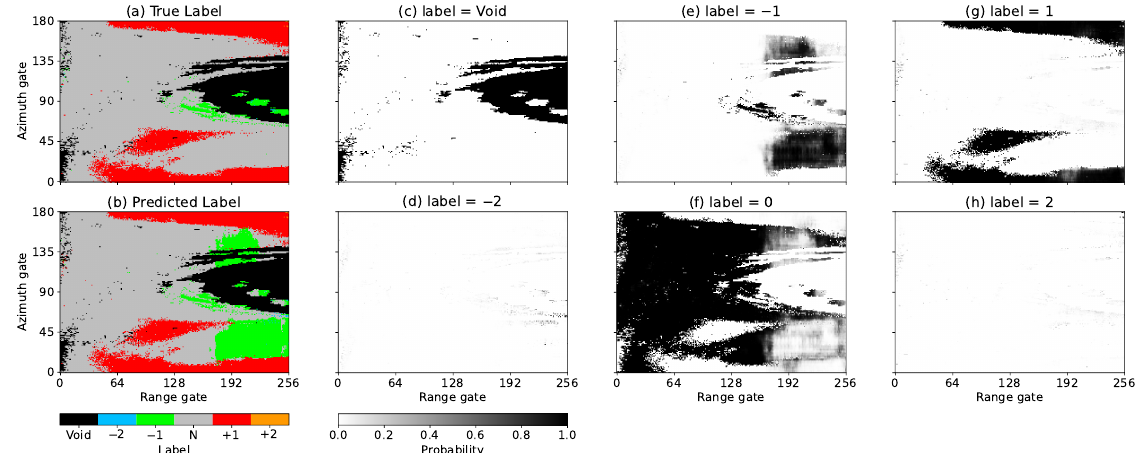
Figure 5. An example of failed prediction with non-speckle echoes: Panel ( a ) shows the true label, which is synthesized using a 0.88 ◦ -EL scan from the KTLX on 16 January 2017 06:33 UTC; Panel ( b ) shows the predicted label; Panels ( c – h ) represent the probability of each label from the CNN model. One can see that the green patch near azimuths 0–45 ◦ at far ranges is incorrectly predicted. The correct label ( L = 0), however, has a significant probability value, which would result in a correct prediction if